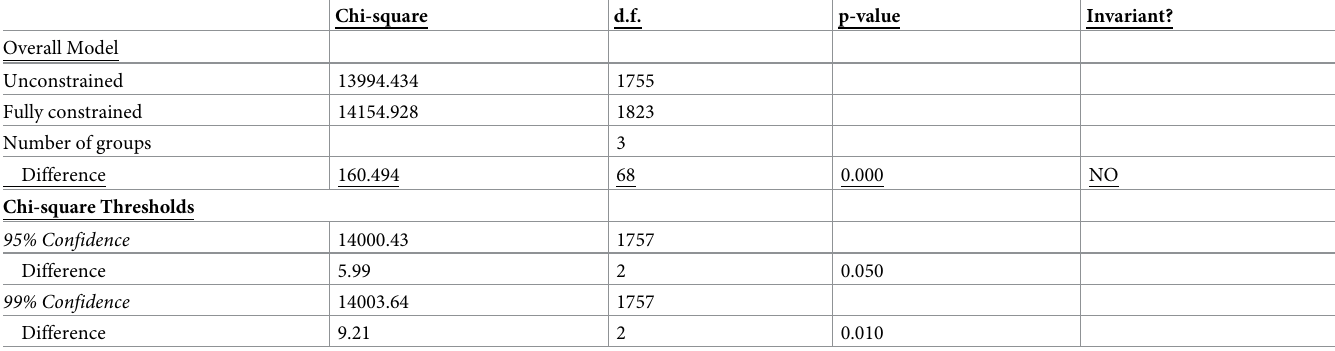
Table 9. Chi-square test